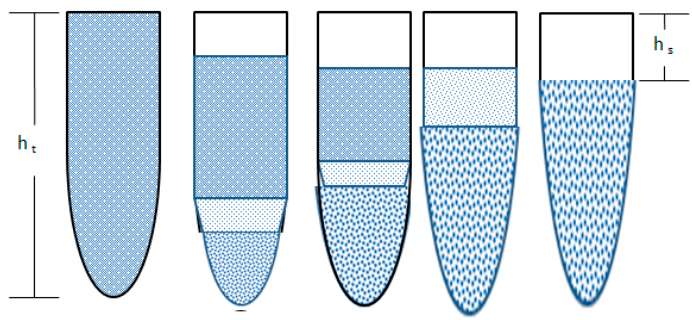
Figure 4. Process to measure emulsions sedimentation based on UNE-EN 12847. h s is the supernatant phase and h t is the initial phase.